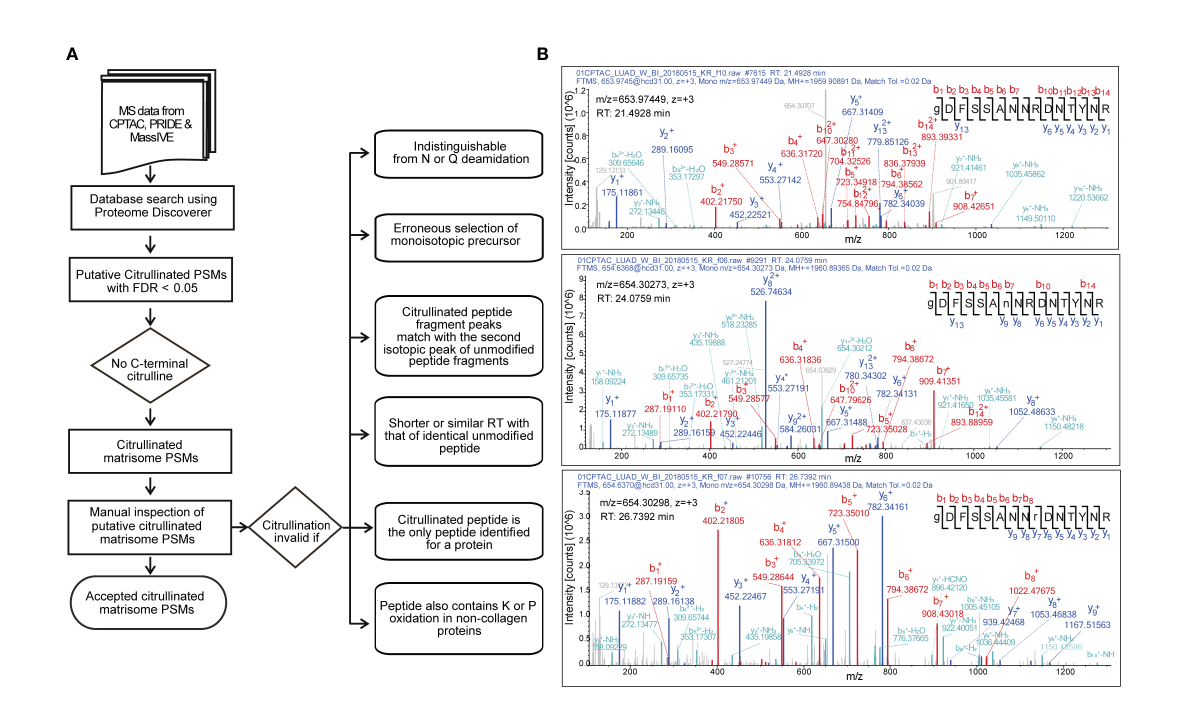
FIGURE 1 Selection of citrullinated matrisome PSMs. (A) A decision tree to accept citrullinated PSMs. (B) Example of MS/MS spectra matching to unmodi fi ed (top), N-deamidated (middle) and citrullinated (bottom) peptide GDFSSANNRDNTYR of fi brinogen alpha chain from CPTAC lung adenocarcinoma dataset. Although the m/z values of the citrullinated and deamidated precursors are nearly identical, citrullination (r) can be distinguished from deamidation (n). In the bottom spectrum, the existence of y ions 2 to 6 along with b ions 7 and 8 leads to a conclusion that the m/z value of the y7 ion can only be due to citrullination. Retention time (RT) differences with unmodi fi ed and deamidated forms give even further evidence for